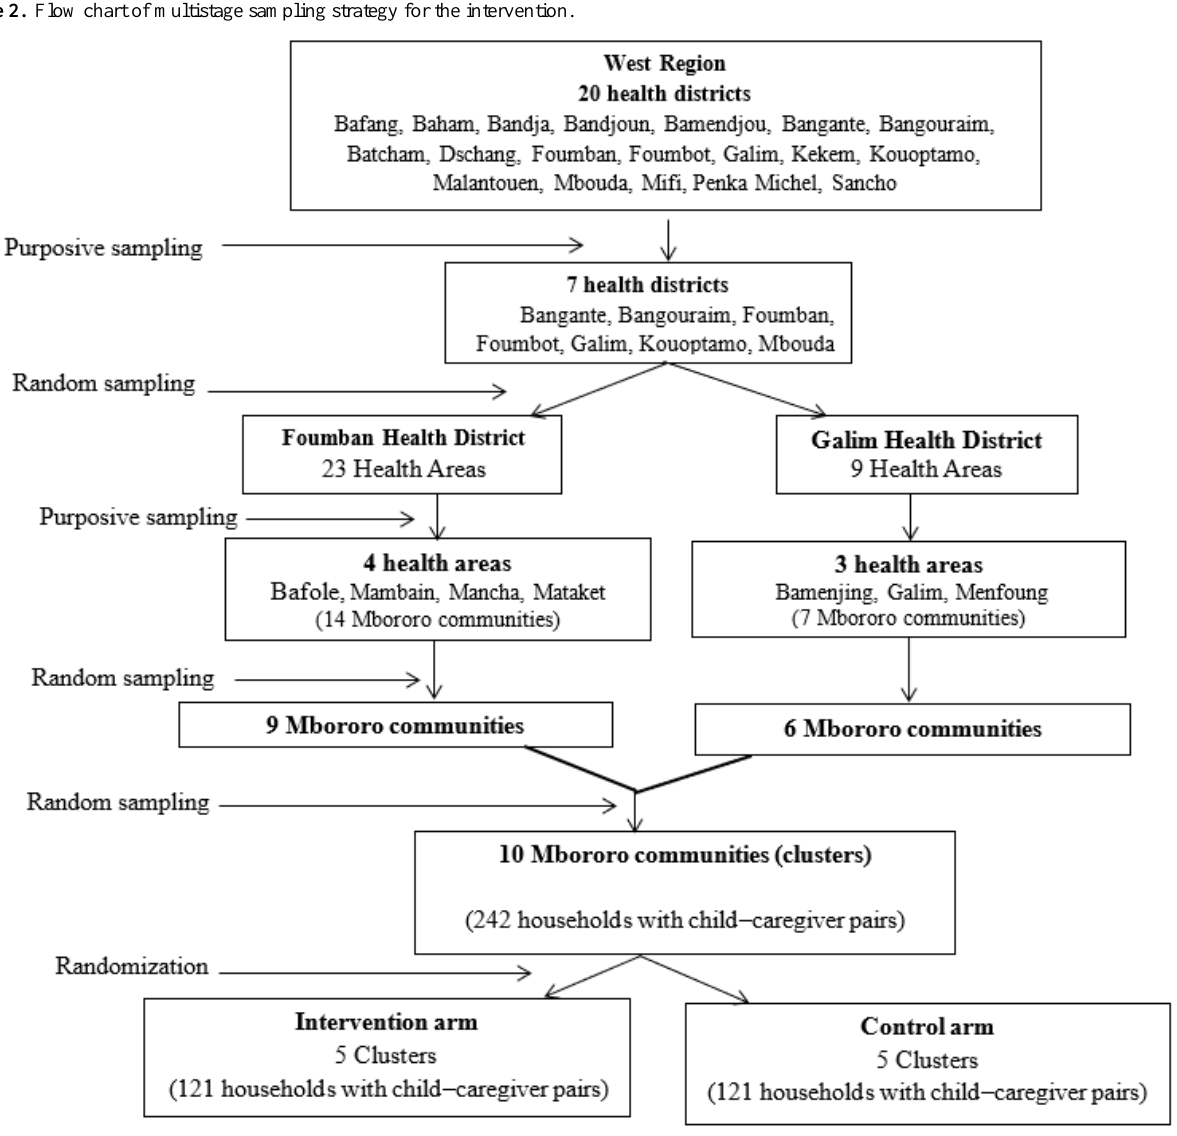
Figure 2. Flow chart of multistage sampling strategy for the